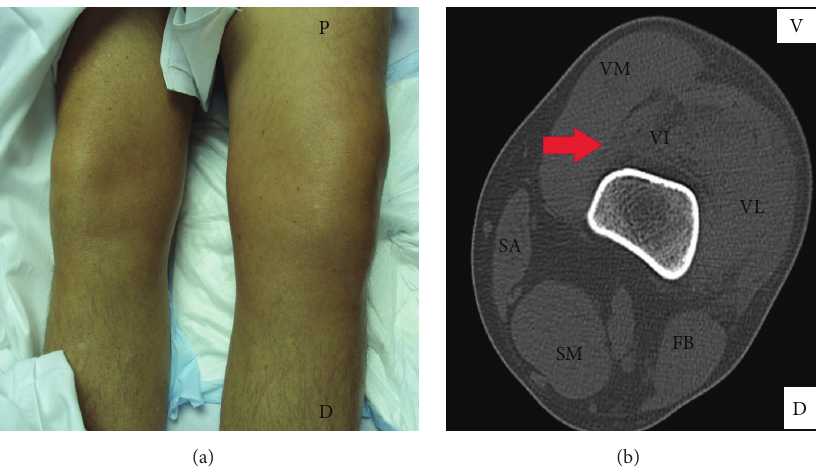
Figure 1: (a) Asymmetry can be observed between the two limbs due to swelling in the left thigh. P: proximal. D: distal. (b) The CT scan shows the presence of a perifemoral haematoma (indicated by the red arrow). The haematoma affects the vastus intermedius (VI) and a small image of active bleeding is visible in its interior. V: ventral. D: dorsal. VM: vastus medialis. VL: vastus lateralis. VI: vastus intermedius. SA: sartorius. FB: femoral biceps. SM: semimembranosus muscle.